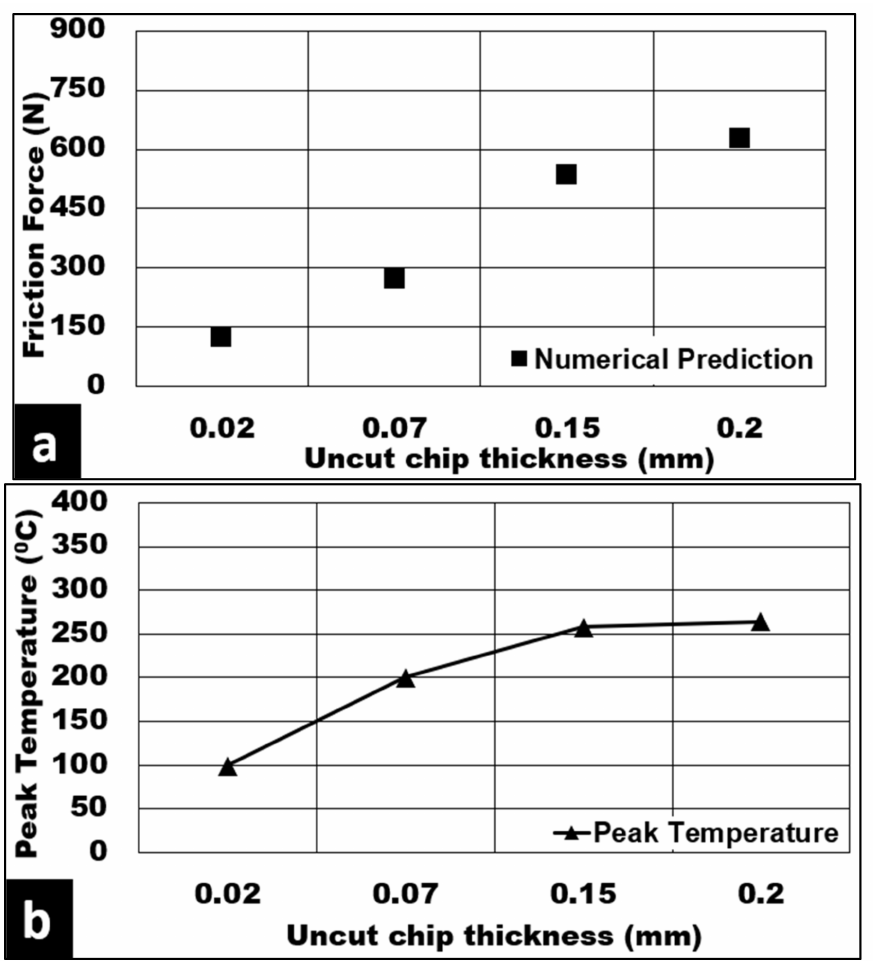
Figure 6. ( a ) Numerical friction prediction values from the 2D-FE model and ( b ) predicted peak temperature distribution for 6061/hollow alumina syntactic foams (AdvantEdge TM ) (vol% = 10%, Vc = 50 m/min, Dry